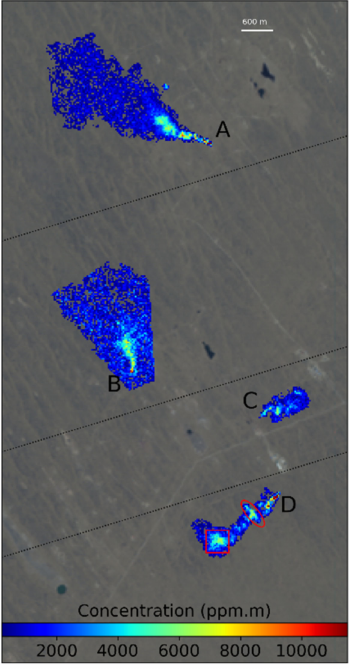
Figure 7. The background of this figure is a PRISMA RGB image. The color scale represents the concentration maps (in ppm · m) for the four sources obtained from PRISMA images (source A: 2021/06/22, source B: 2020/11/14, source C: 2020/08/07, source D: 2020/10/10). The red rectangle and ellipse highlight an overestimation of the concentration linked to the presence of bright sand